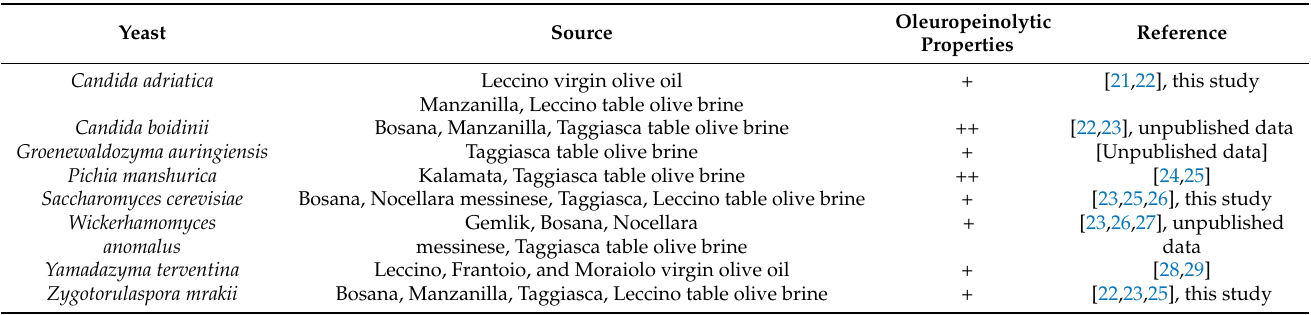
Table 1. Oleuropeinolytic yeasts from table olive brine and virgin olive oil used in the laboratory tests.